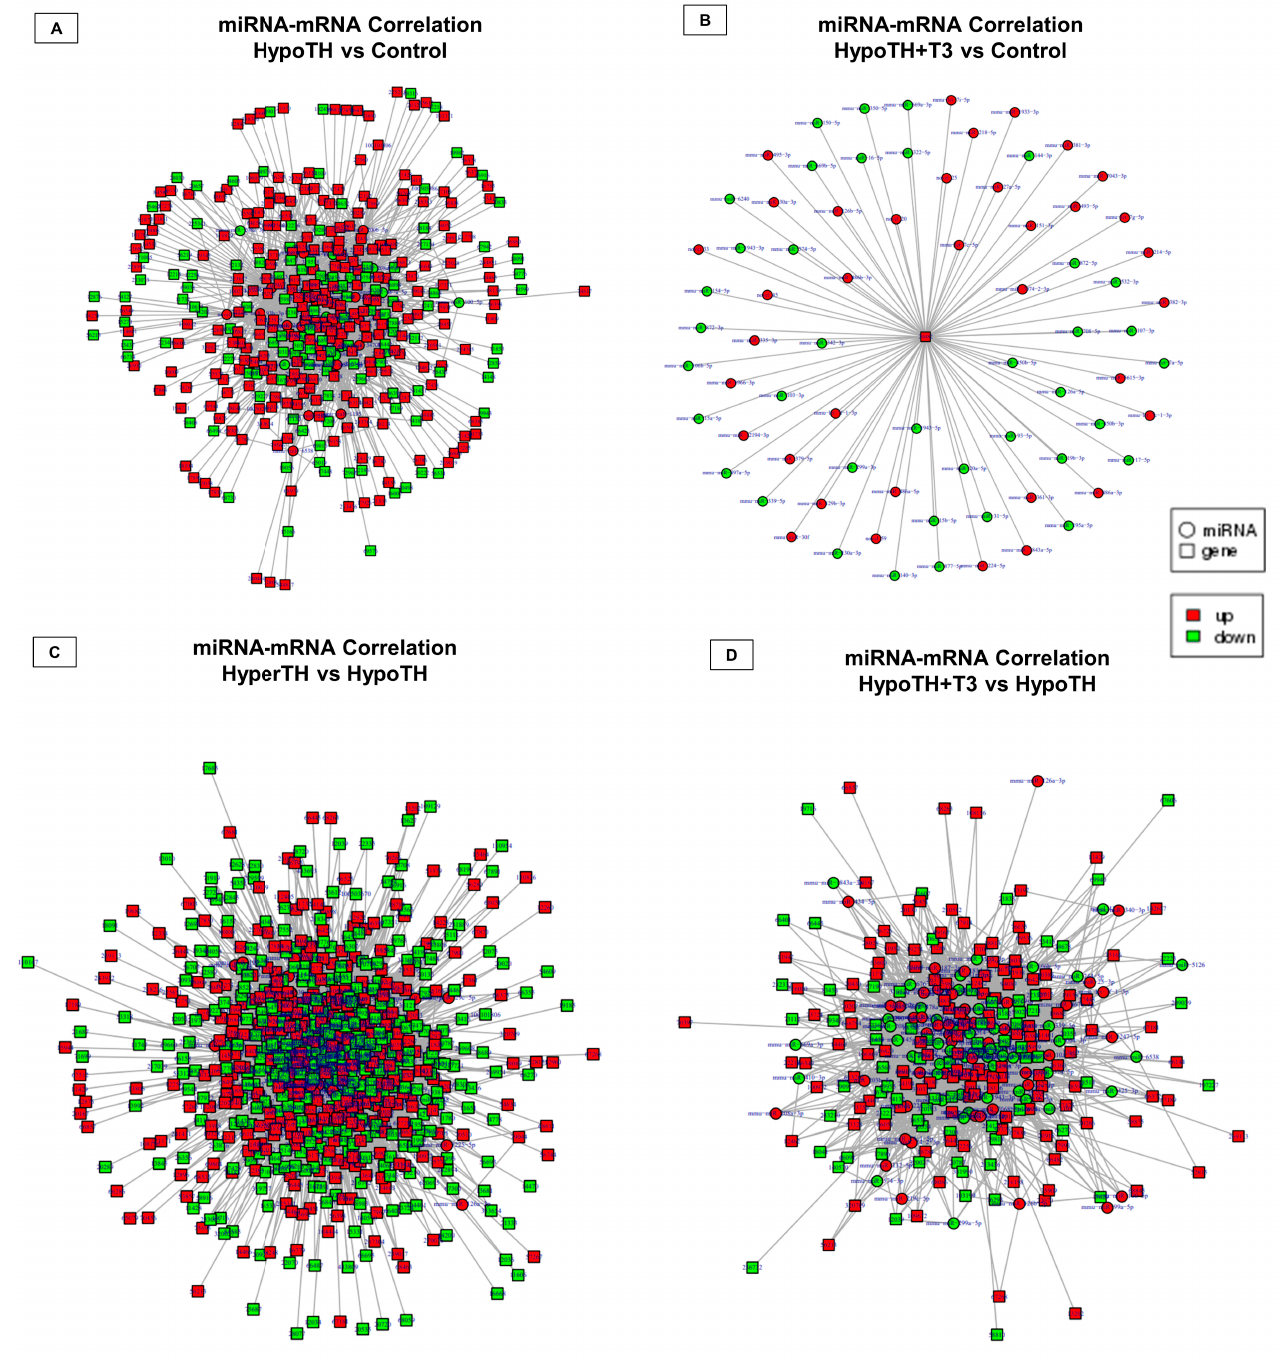
Figure 10. miRNA-mRNA correlation analysis. Groupwise comparisons identified the miRNA- mRNApartners in ( A ) HypoTH vs. Control, ( B ) HypoTH + T3 vs. Control, ( C ) HyperTH vs. HypoTH, ( D ) HypoTH + T3 vs. HypoTH groups. The interaction network images were prepared in Cy- toscape. Only statistically significant ( p -adj/corr < 0.05) and differentially expressed miRNA and mRNA targets were included in this network analysis. Upregulated targets are marked in red and downregulated targets are marked in